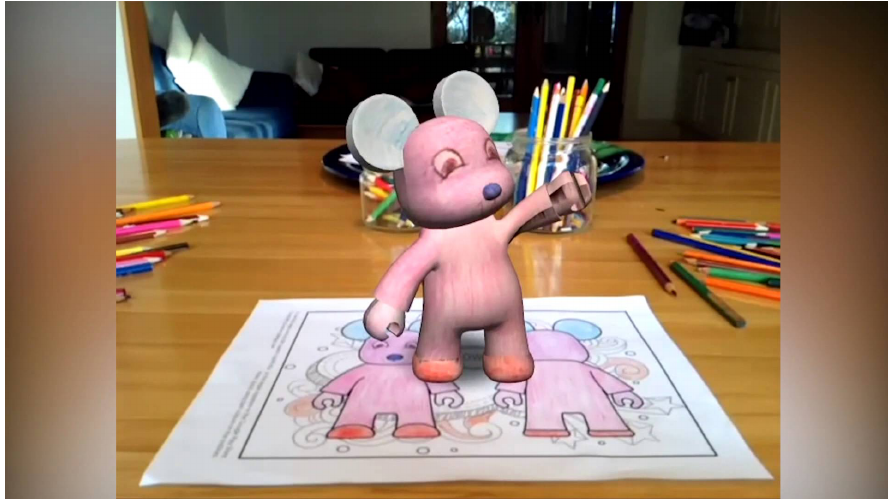
Figure 3. A sample of AR using a pictorial marker.